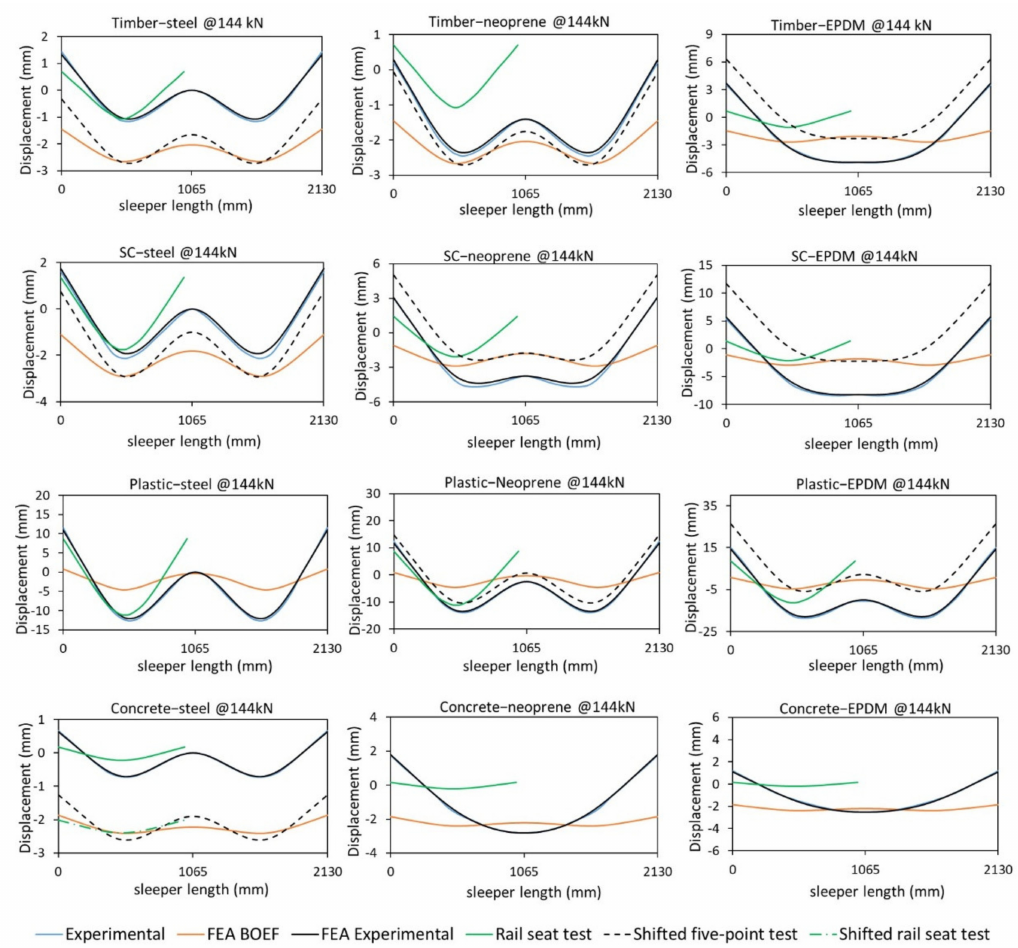
Figure 10. Full-length deflection shape of the sleepers for different support